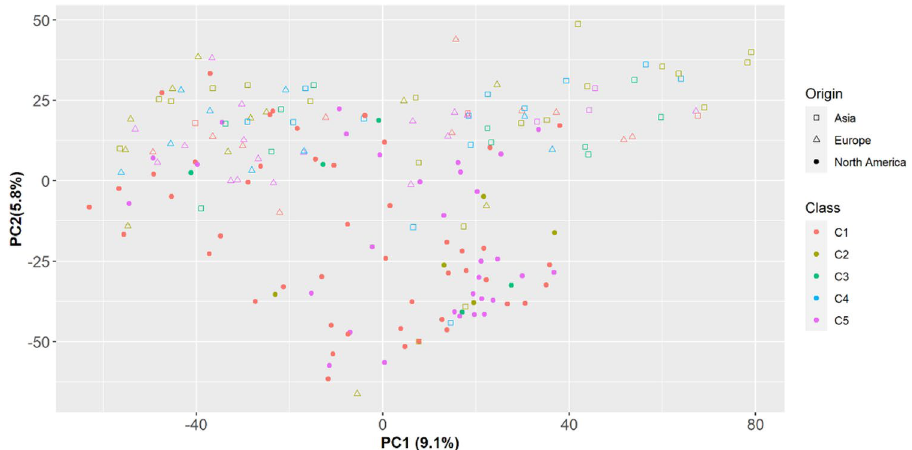
Figure 4. Population structure of rapeseed/canola genotypes as reflected by the scatter plot of PC1 and PC2 derived from a principal component